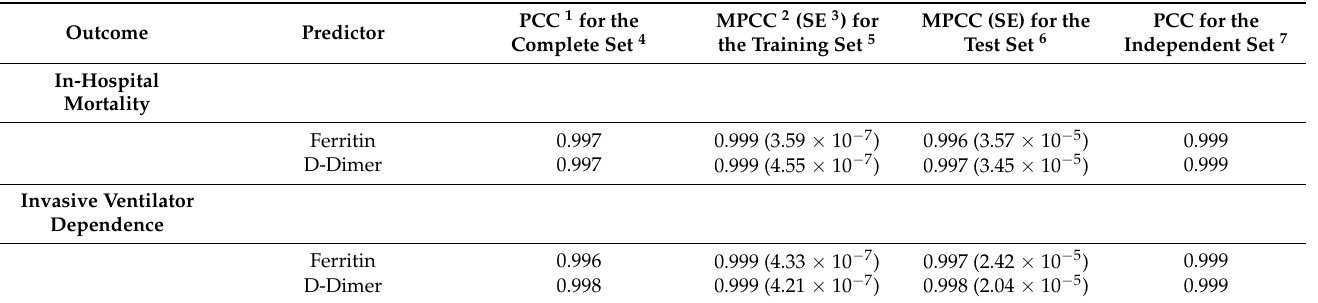
Figure 1. Receiver operating characteristic (ROC) for the optimal cutoff of ferritin (ng/mL) in predicting in-hospital mortality. Table 4. Cross-validation diagnostics of ferritin and D-dimer optimal cutoffs in predicting in-hospital mortality and invasive ventilator